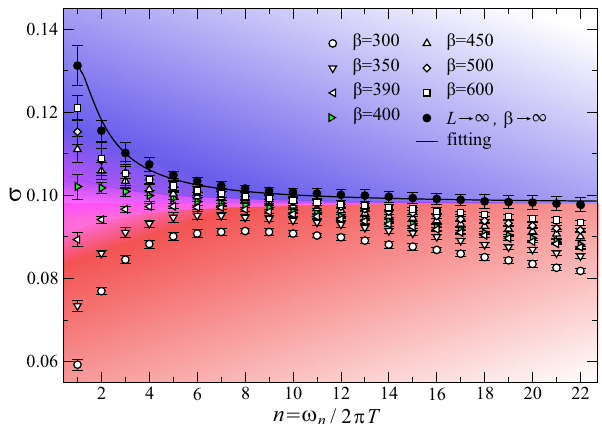
Fig. 2 Conductivity fractionalization and dynamical self-duality at half- fi lling. Longitudinal conductivity data, including a two-step extrapolation from fi nite sizes and temperatures to the low- T thermodynamic limit, of our kagome model at boson fi lling 〈 n i 〉 = 1/2 as a function of n = ω n /2 π T at the XY * critical point ( t / V ) c = 0.070756(20) with L = 12,24,36,48,60,72,96 and β V = 300,350,390,400,450,500,600. In the thermodynamic limit, L → ∞ and then β → ∞ , the universal constant σ XY (cid:3) ð1Þ appears, and we obtain a σ ð1Þ . At fi nite plateau value of σ XY (cid:3) ð1Þ ¼ 0 : 098 ð 9 Þ which is 1 XY 4 temperatures, we see a crossover from a particle-like conductivity (blue) to a vortex-like one (red). In the vicinity of β * ≈ 400 (c.f. the green triangles), we observe a nearly constant dynamical conductivity indicating a self-dual- quantum fl uid with visons.